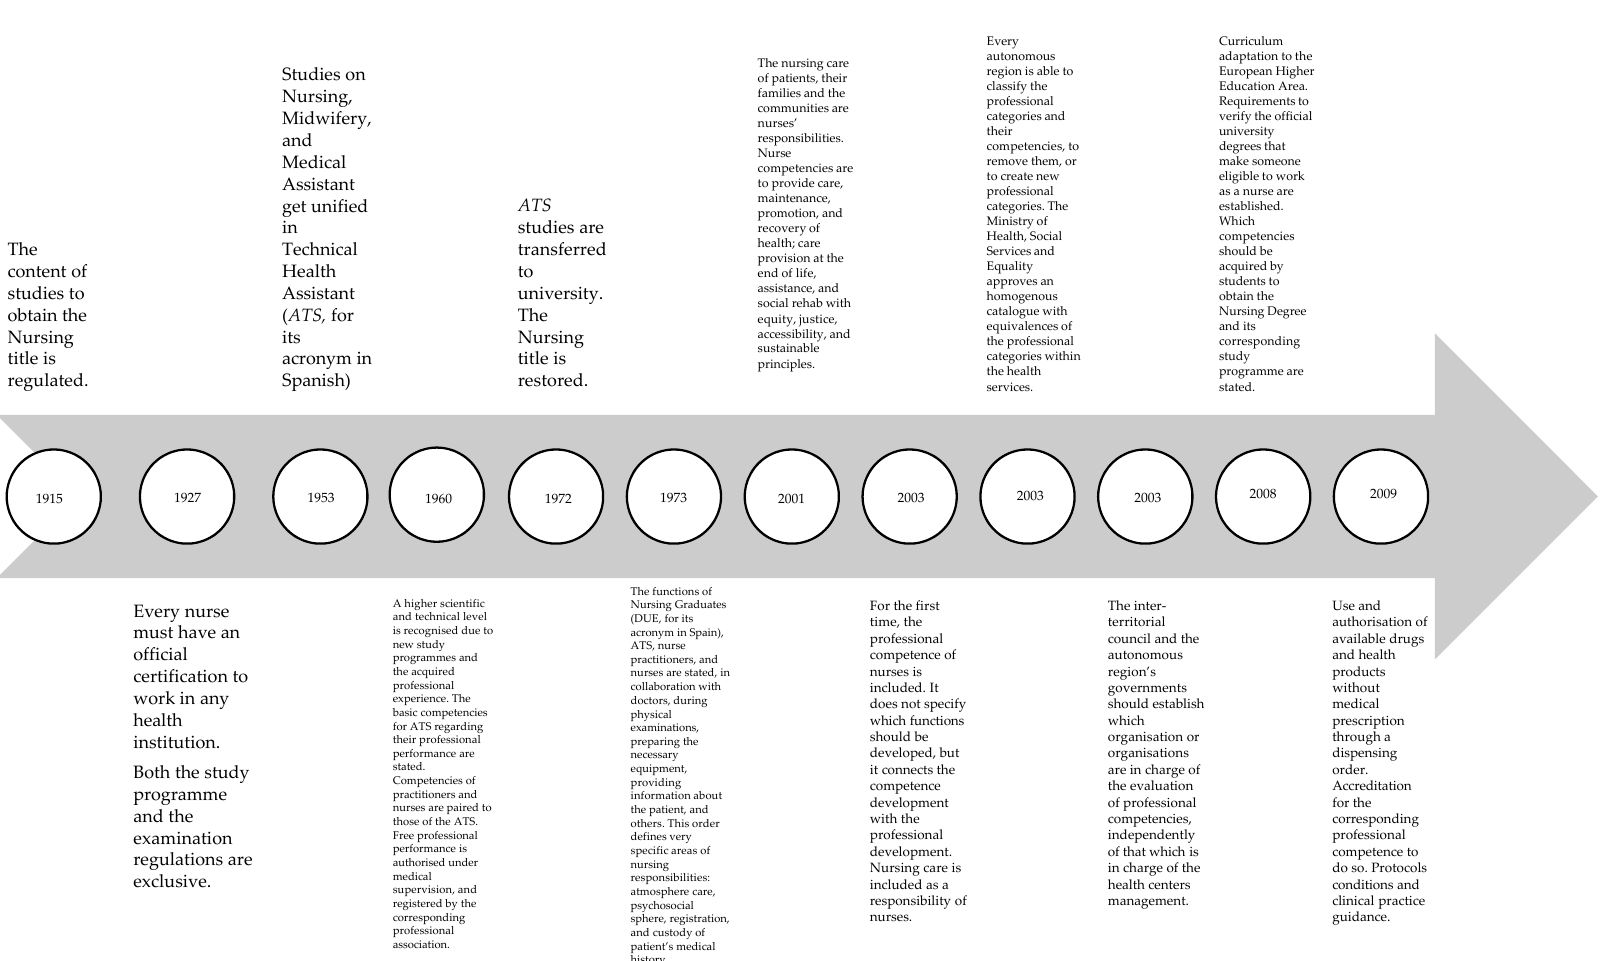
Figure 1. Spanish legislation on clinical and nursing training